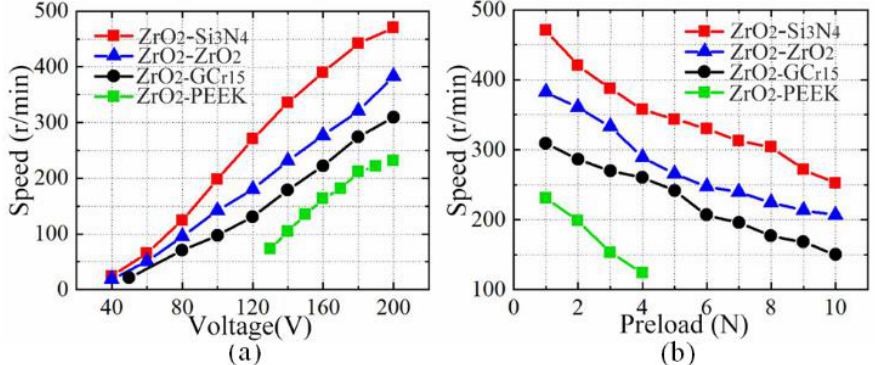
Figure 3. Characteristics of speed. ( a ) Relationship between the velocity and excitation voltage char-